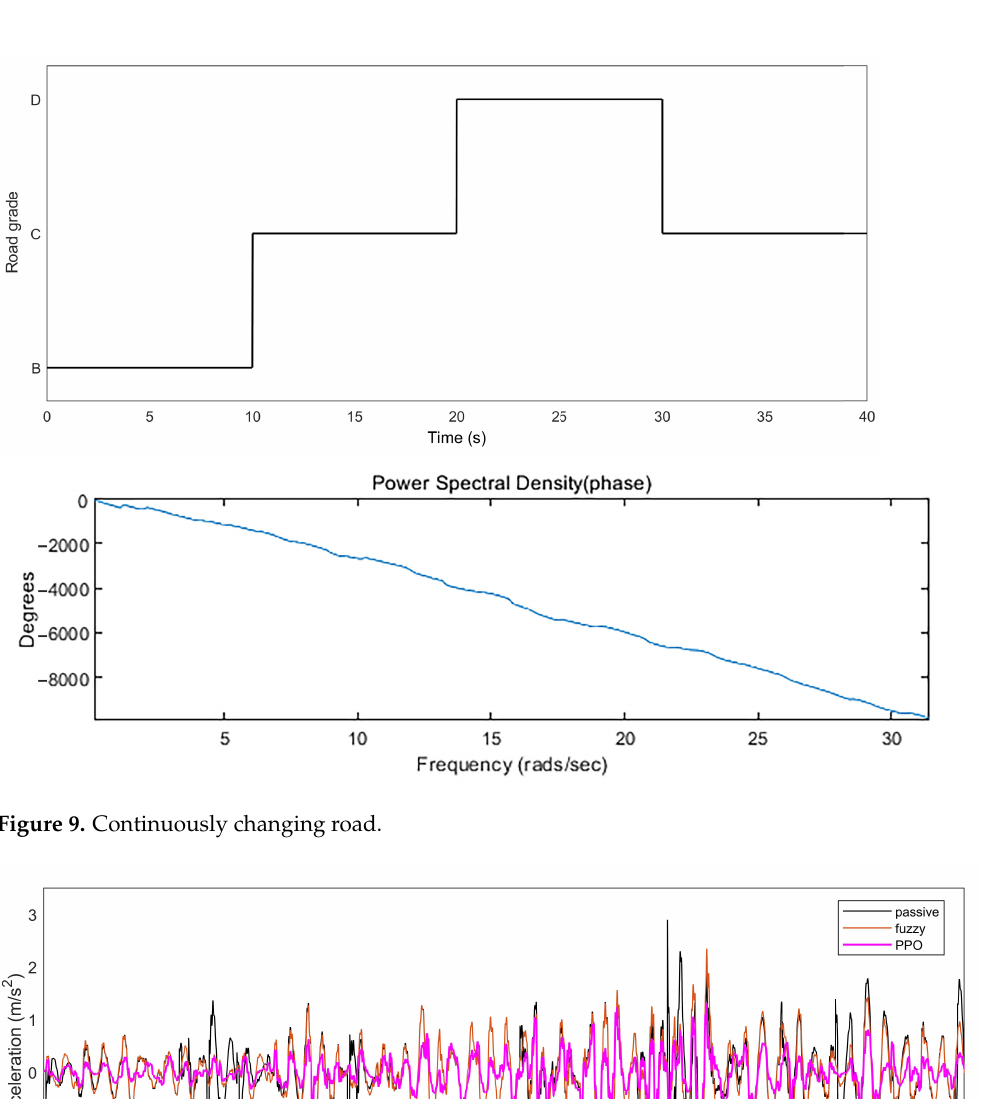
Figure 10. Body acceleration under continuously a changing road of PPO, passive, and fuzzy suspension systems for a light